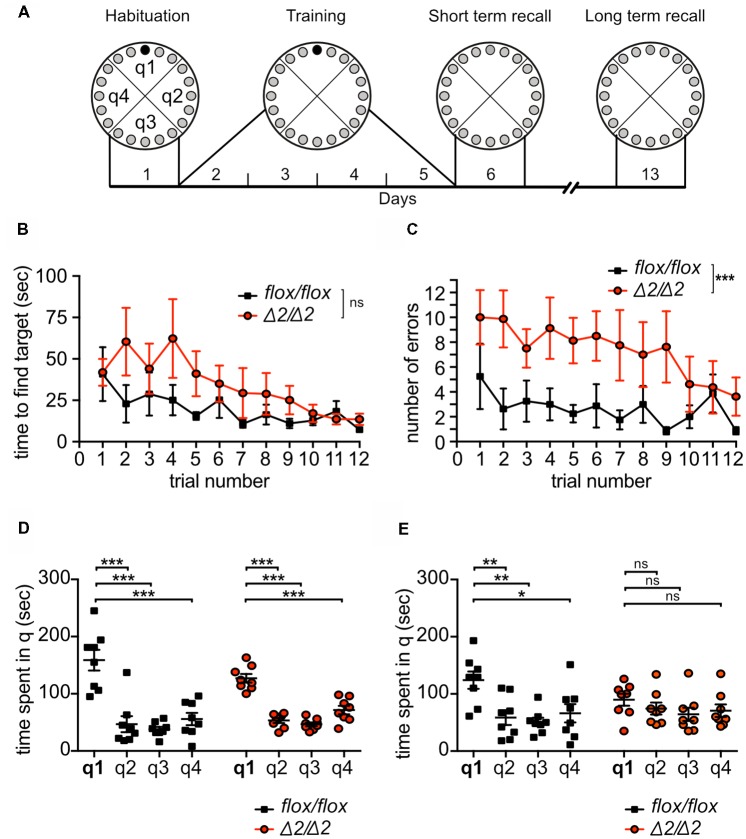
Learning and long-term memory deficits of Chd1Δ2/Δ2 mice in the Barnes Maze (BM) test. (A) Schematic representation of BM experimental set-up. Animals were trained during 4 days with three training trials on each day to find the target hole (black circle). On day 6, all holes were closed and animals were tested for short-term memory. On day 13, animals were tested for long-term memory. (B,C) Learning was monitored by recording the time required to find the target hole (latency; B) and by determining the number of errors before finding the target hole (C) during each training trial. Statistical analysis was performed by two-way repeated measures ANOVA (n = 8/group). (D,E) Short term memory (D) and long-term memory (E) were assessed by recording the time spent in each quadrant in the test trial at day 6 (D) and 13 (E). Statistical analysis in (D,E) was performed by one-way ANOVA for each genotype (n = 8 per group). q1–4, quadrants 1–4; q1 is the target quadrant. Means ± SEM are shown. Statistical significance threshold was set to p < 0.05 (*p < 0.05, **p < 0.01, ***p < 0.001, ns, non-significant).